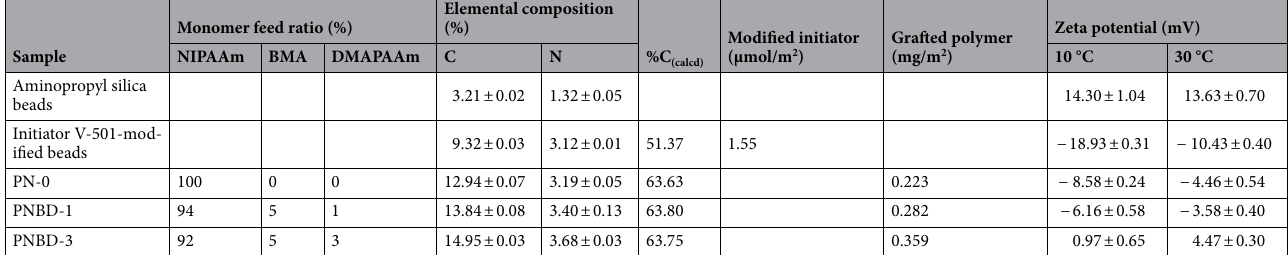
Table 1. Properties of the initiator- and polymer-modified beads. The samples are abbreviated using the initials of the monomers used to fabricate them (i.e., NIPAAm, BMA, and DMAPAAm) and their DMAPAAm content. The carbon content was estimated using elemental analysis, and the values are expressed as means ± standard deviations (n = 3). The %C (calcd) values were calculated as the theoretical carbon contents of the initiator and polymers of the molecules. The amounts of initiator and polymer grafted onto the silica beads were calculated using their respective carbon content. The zeta potentials were measured using a zeta potential analyzer, and the values are expressed as means ± standard deviations (n = 3).